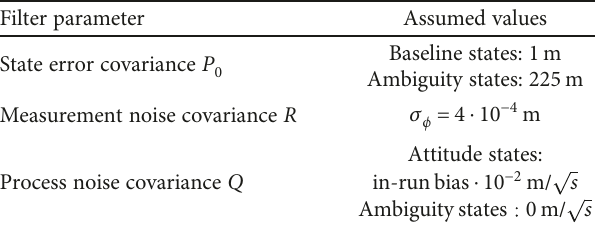
Table 1: Baseline fi lter assumed parameters, same as in